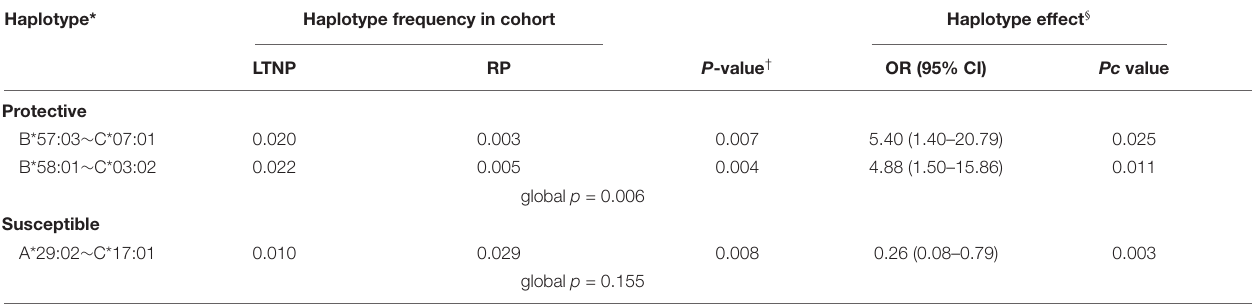
TABLE 4 | Haplotype frequency and association with